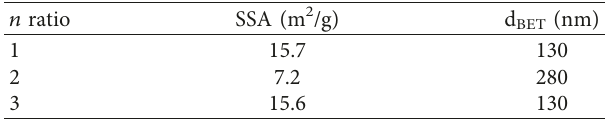
Figure 4: FTIR spectra of powders obtained from systems containing different amounts of urea. Table 3: Influence of n ratio on the specific surface area and particle size of as-synthesized